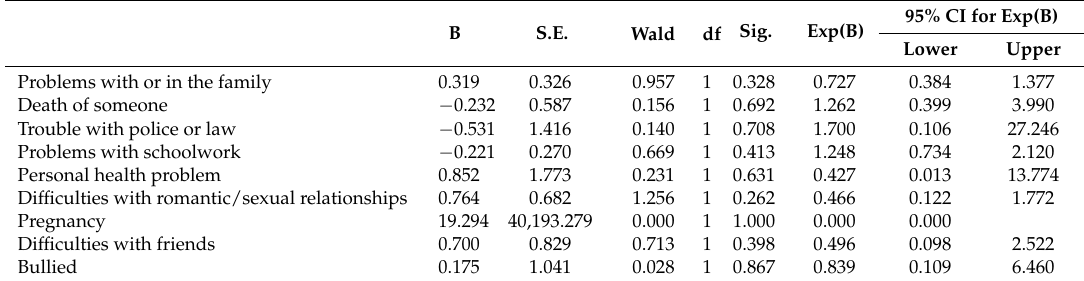
Table 6. D-SIB and life event categories in vocational school